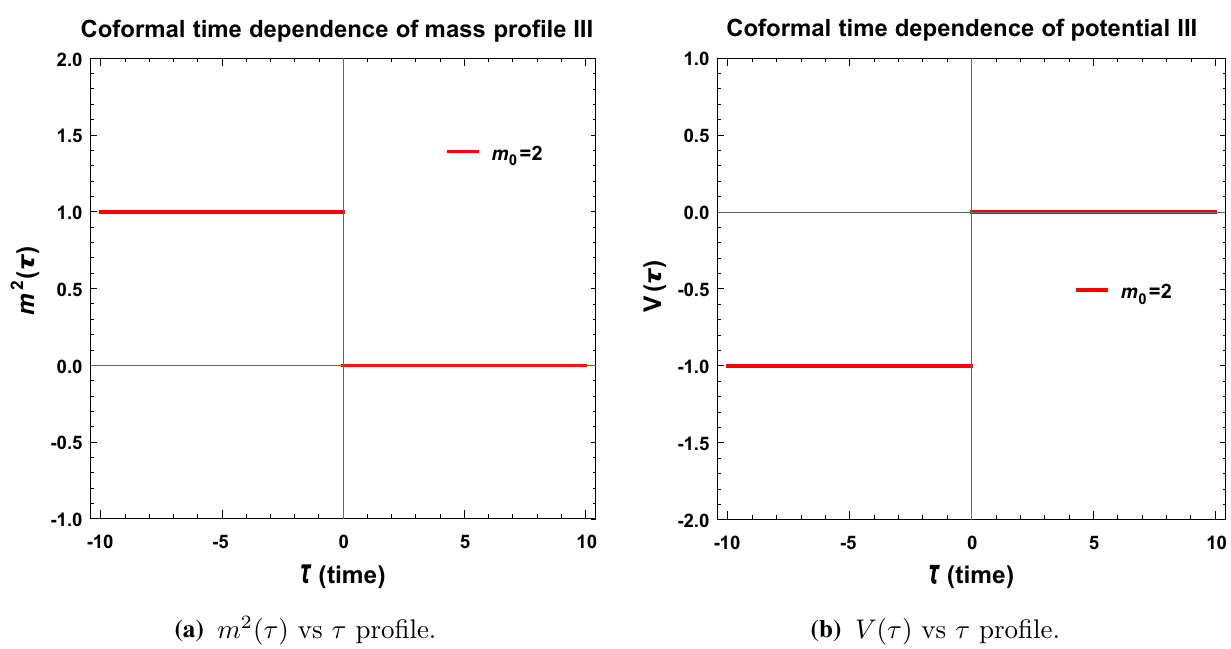
Fig. 15 Conformal time dependent behaviour of the mass profile II and its corresponding potential used in Schrödinger scattering problem is explicitly shown